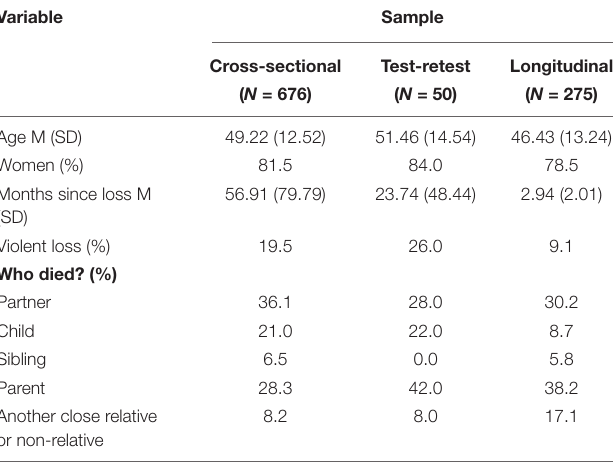
TABLE 1 | Sample demographics and loss